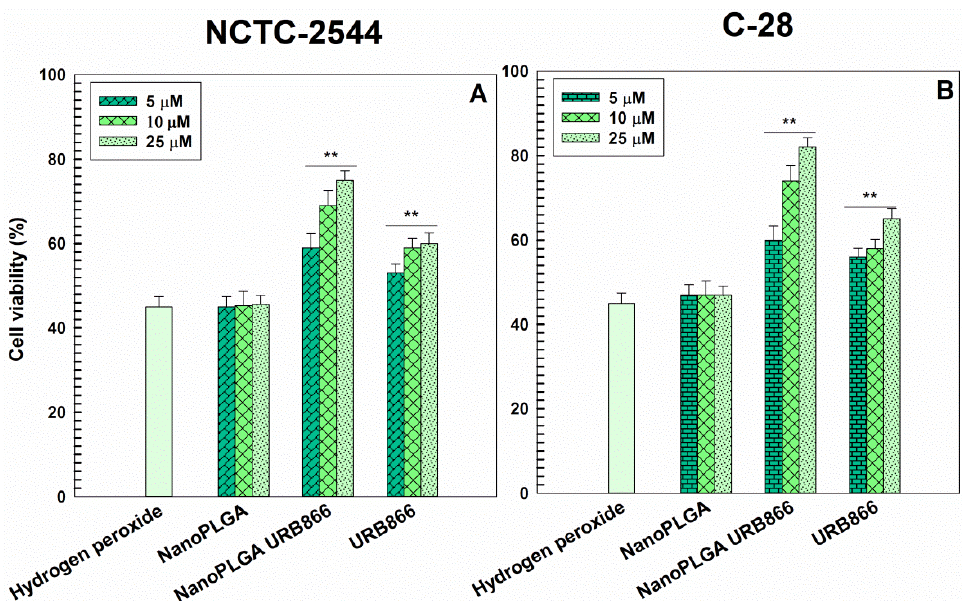
Figure 7. Antioxidant activity of URB866 in the free form or encapsulated within PLGA nanoparticles on NCTC2544 ( A ) and C-28 cells ( B ). The cells were incubated with different concentrations of URB866 for 24 h and then treated with H 2 O 2 (800 µ M) for 1.5 h. At the end of the incubation time, the MTT test was carried out. The results are the mean of three different experiments ± standard deviation. Statistical analysis: **, p <0.001 vs. hydrogen peroxide.